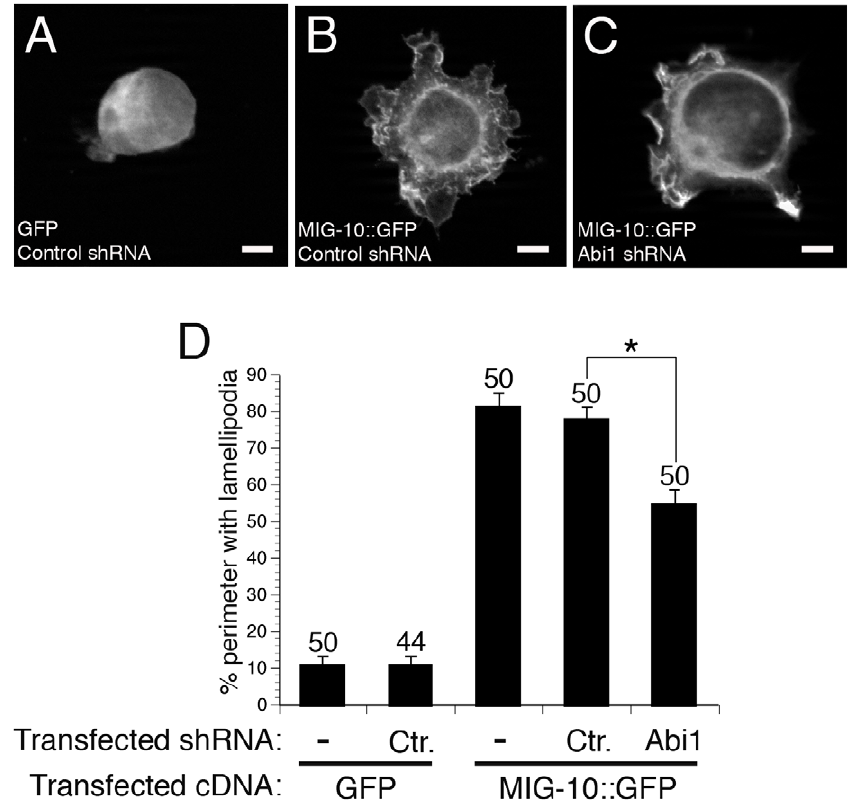
Figure 5. ABI-1 mediates the lamellipodia-forming activity of MIG-10 in cultured HEK293 cells. (A) Example of cell transfected with GFP and control shRNA. (B) Example of cell transfected with MIG-10::GFP and control shRNA. (C) Example of cell transfected with MIG-10::GFP and Abi1 shRNA. (D) Knockdown of Abi1 suppresses the lamellipodia-forming activity of MIG-10. Graph shows the average cell perimeter with lamellipodia. ‘‘Ctr.’’ means cells transfected with scrambled control shRNA. ‘‘ 2 ’’ means cells were not transfected with any shRNA. ‘‘Abi1’’ means cells were transfected with the PAV197 shRNA against Abi1. Error bars represent the standard error of the mean. *Bracket indicates statistically significant difference, t-test (p , 0.0001). Scale bars are 5 m m.